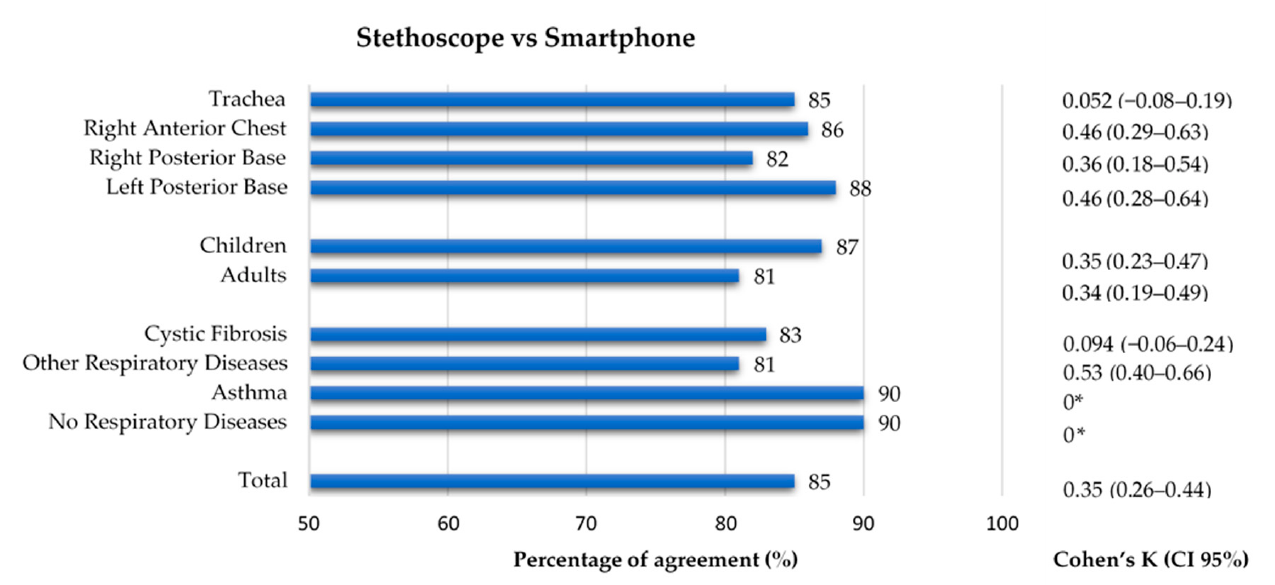
Figure 6. Agreement between conventional and smartphone auscultation regarding the presence of adventitious sounds by location, age group and diagnostic group. * Cohen’s Kappa was not calculated as data from conventional auscultation was constant.